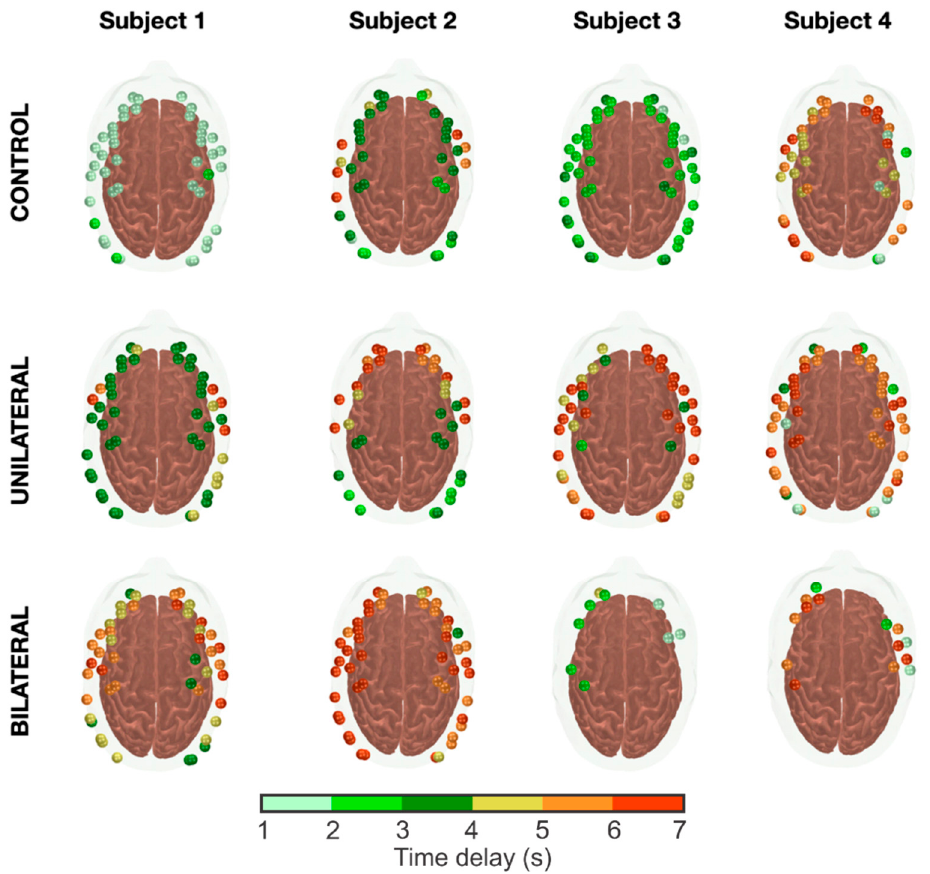
Figure 5. Individual responses to the breath-holding challenge from four arbitrary subjects within each group. Each sphere on the head represents an fNIRS channel that showed a significant vasodilatory response (as measured by a significant increase in HbT) following apnea. The color bar represents the time delays of the modeled HRF that maximizes the fit of the measured time courses.